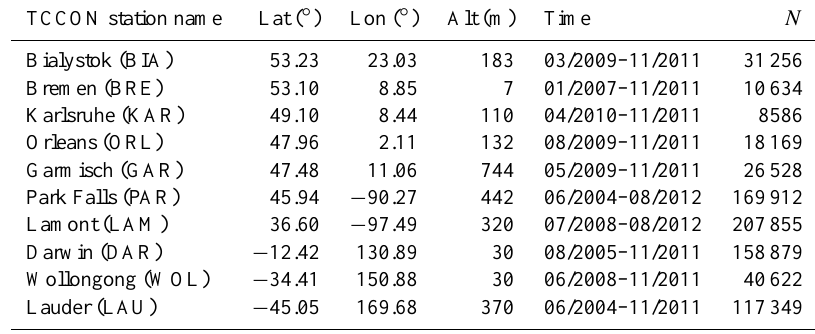
Table 2. List of all participating TCCON stations, their location, time coverage and number of data points ( N